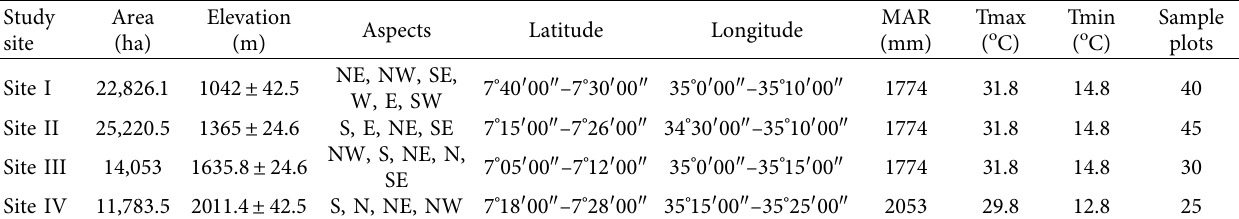
Table 2: Locations and topographic characteristics of studied forests.